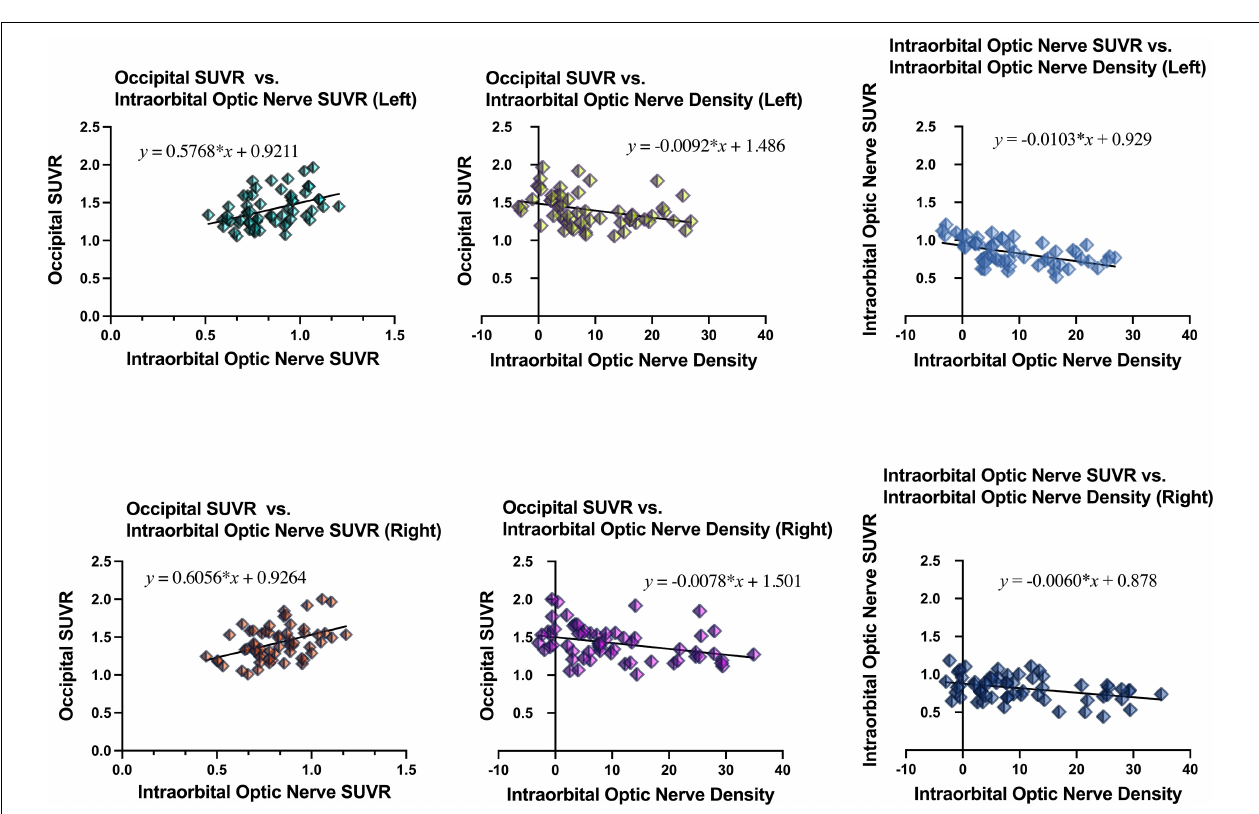
FIGURE 3 | Results of simple linear regression between the occipital SUVR and the intraorbital optic nerve SUVR, between the occipital SUVR and the intraorbital optic nerve density, and between the intraorbital optic nerve SUVR and the intraorbital optic nerve density.